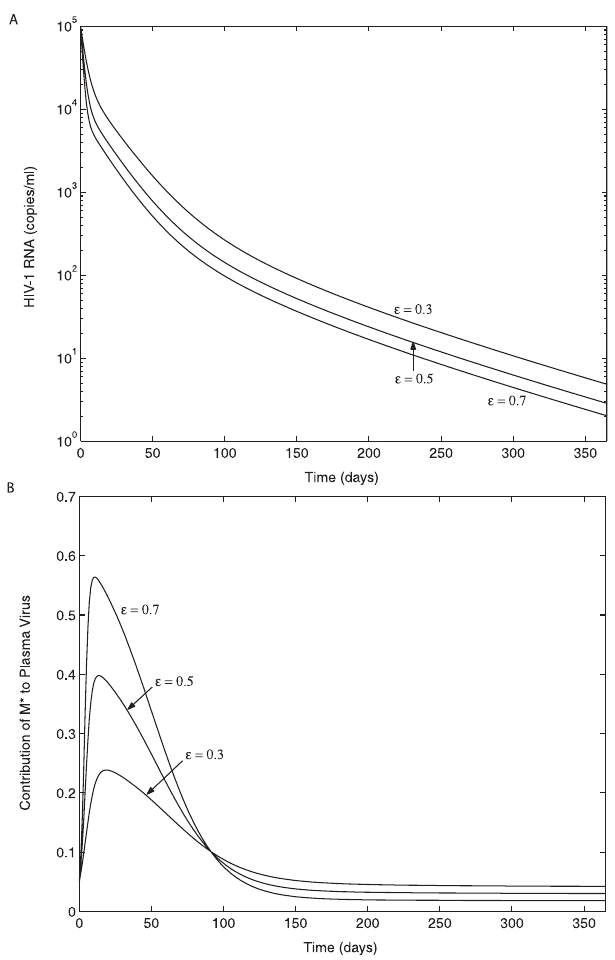
Figure 6. Simulated Decay Dynamics of HIV-1 after the Initiation of ART The initial conditions and parameters used in the simulation are given in Materials and Methods. The results are shown for three different drug efficacies ( e ¼ 0.3, 0.5, and 0.7). (A) Viral decay profile. (B) Contribution of long-lived infected cells to plasma virus ( / 1 ( t ) ¼ p M M* ( t ) / ( N d T* ( t ) þ p M M* ( t